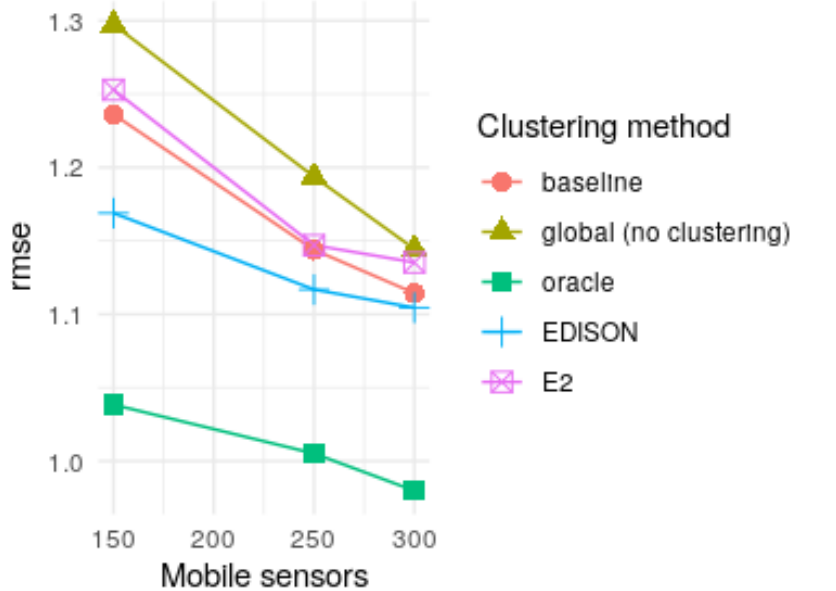
Figure 8. RMSE values. While interpolation with oracle clustering results in the lowest RMSE values, EDISON improves on both the baseline clustering as well as an unclustered, global